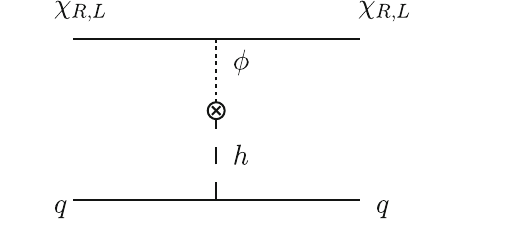
Fig. 6 The χ L , R -quark scattering process yielding the spin- independent elastic cross section of a dark matter. The kinetic mixing is denoted by the cross. The cross in a circle stands for the mixing between φ and h